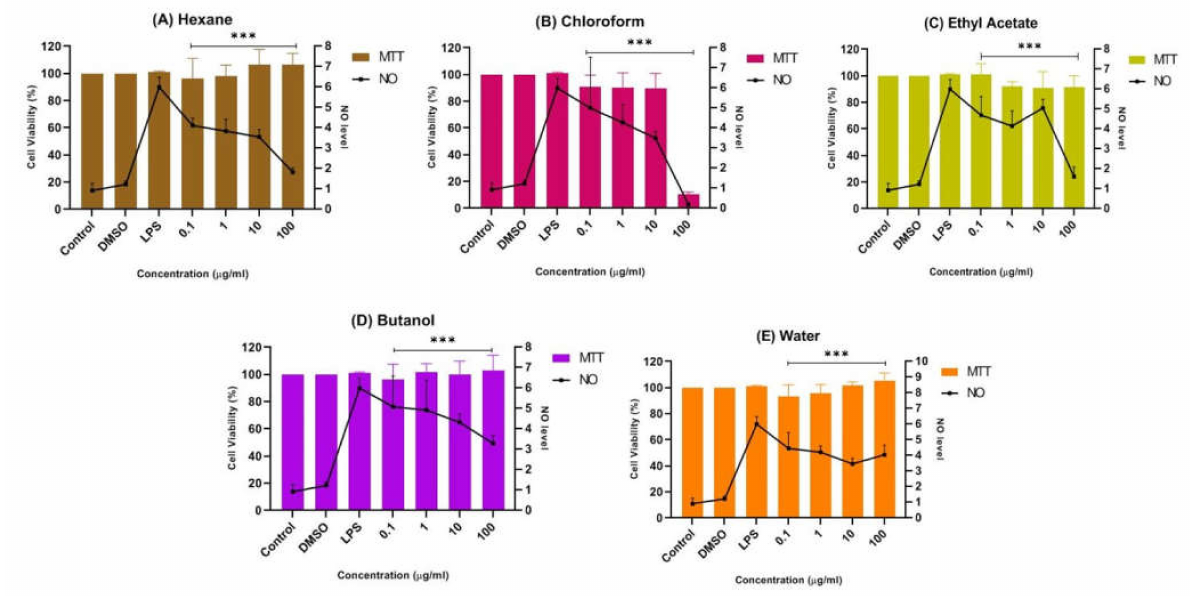
Figure 5. Effect of ( A ) n -hexane, ( B ) chloroform, ( C ) ethyl acetate, ( D ) butanol, and ( E ) water fractions of CTF methanolic extract on the production of NO in BV-2 cells after 24 h stimulation by LPS. The NO levels are expressed as mean ± SD of three independent experiments. The extract showed a dose-dependent inhibition of NO release. The values are statistically significant *** ( p < 0.001) compared to LPS